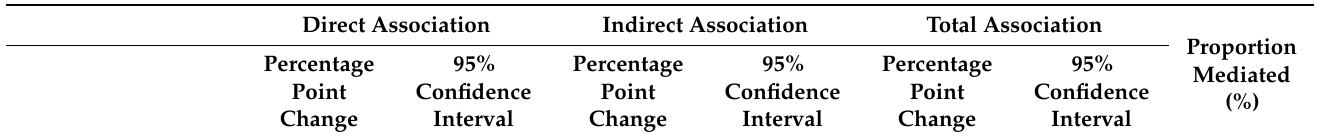
Table A9. Direct and indirect associations of prenatal and post-birth PM 2.5 exposure (defined over 2 months) with infant mortality.